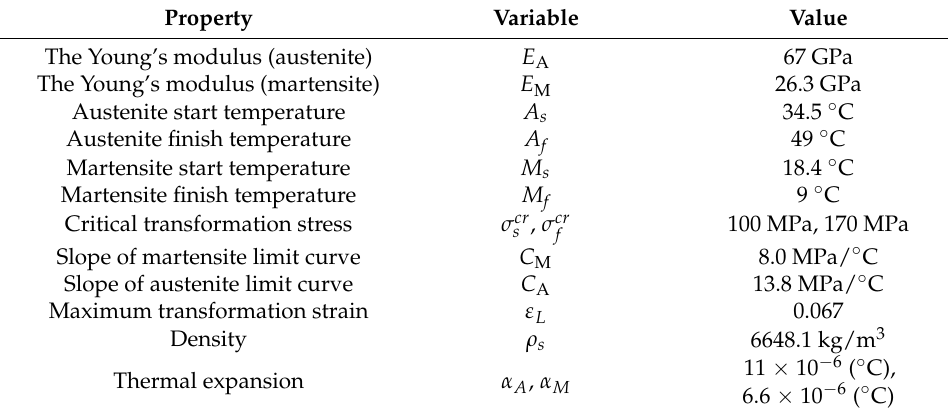
Figure 3. Considered geometry, loading and boundary conditions of the SMAHC plate used to validate the developed model. Table 1. Considered properties of